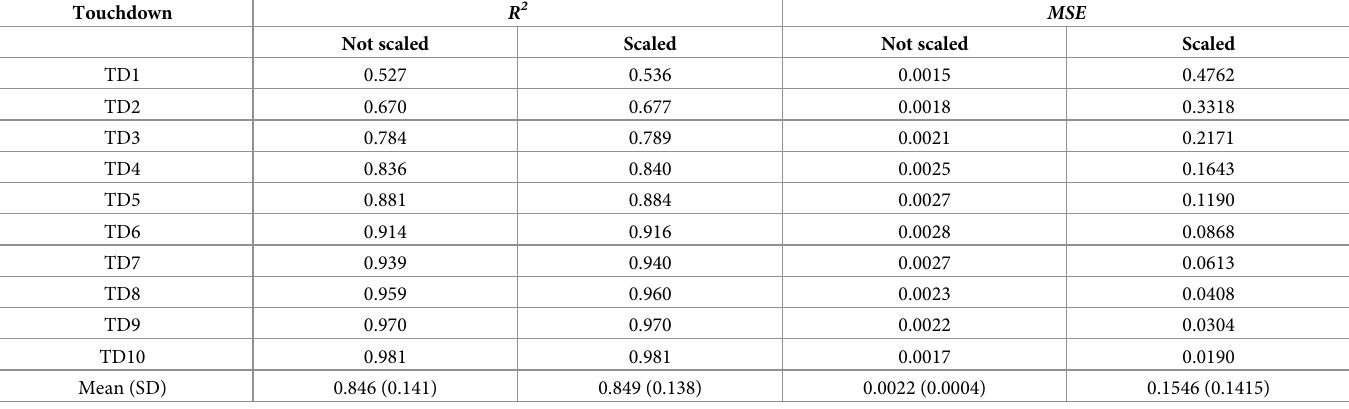
Table 3. Summary of evaluation metrics with unifying the scale of each touchdown time in the present study model.